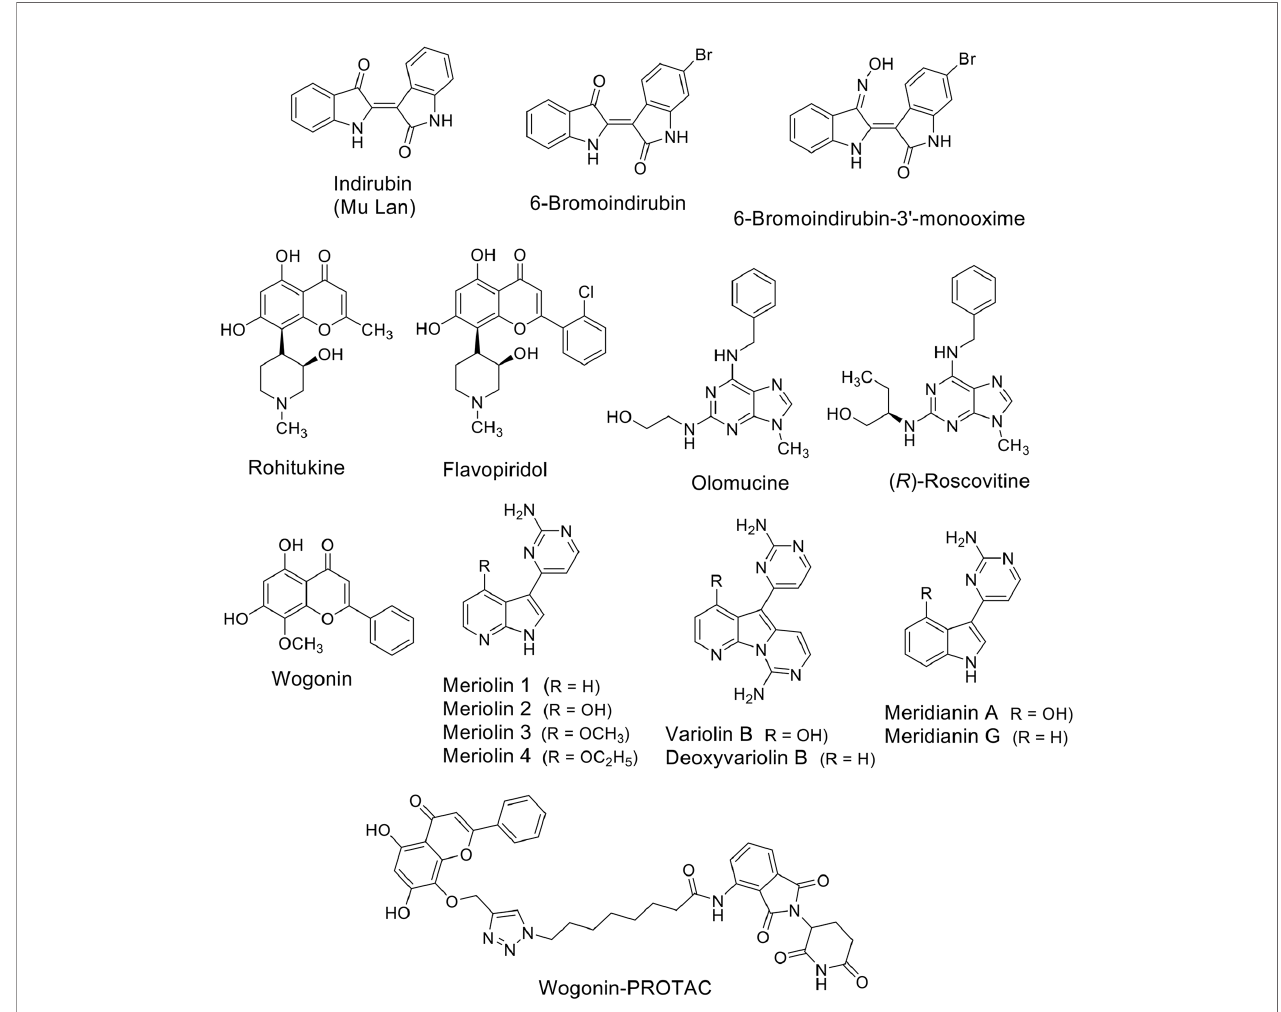
FIGURE 2 | Natural compounds as CDK (CDK9) inhibitors and their synthetic